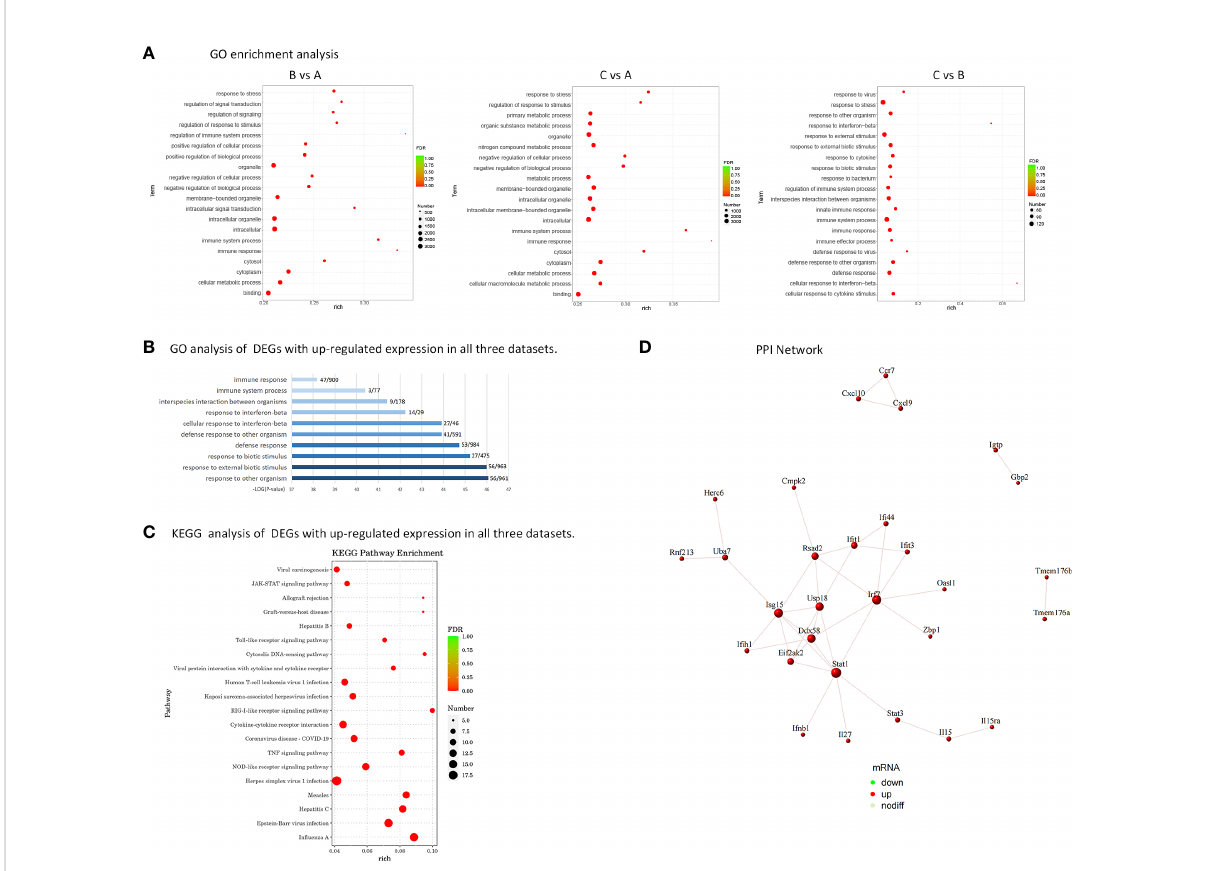
FIGURE 3 Biological analysis of DEGs. (A) GO enrichment analysis of DEGs. Rich factor refers to the ratio of the number of DEGs enriched in the GO term to the number of total genes annotated. The larger the rich factor, the greater the degree of enrichment. FDR generally ranges from 0 to 1, and the closer it is to zero, the more signi fi cant the enrichment is. The top 20 GO Term entries with the smallest FDR value, that is, the most signi fi cant enrichment, are selected for display. (B) Histogram of GO enrichment analysis. 191 DEGs with up-regulated expression in all three datasets were analyzed for GO enrichment. The top 10 GO term entries with the most signi fi cant enrichment in GO are selected for display. The abscissa is the terms of Go level2, and the ordinate is the -log10 (p-value) enriched for each term. The number of the genes identi fi ed in this study vs total gene numbers in the term are shown on the right. (C) Analysis of KEGG enrichment using a bubble plot. KEGG enrichment analysis of 191 DEGs with up-regulated expression. The top 20 KEGG pathways with the smallest FDR value are selected for display. (D) PPI Network - Schematic Diagram of Gene Expression. There are 12 key genes that are more closely